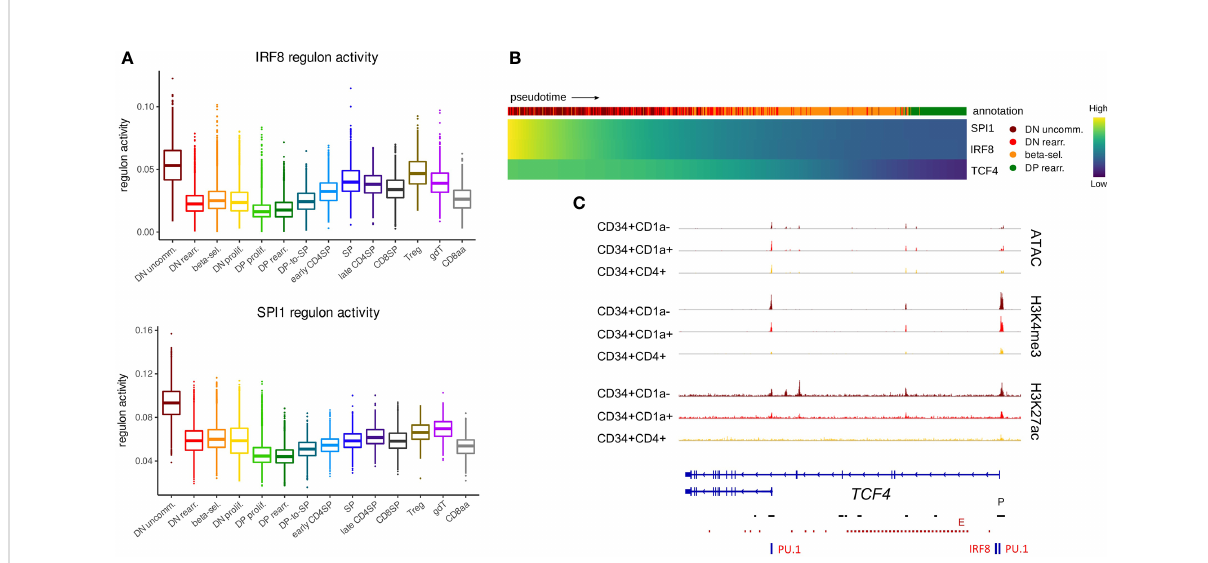
FIGURE 4 TCF4, IRF8 and SPI1 are predicted to form a regulatory network in uncommitted DN thymocytes. (A) Activity of IRF8 and PU.1 regulons per cluster as predicted by running pySCENIC on the single cell data set. (B) Heatmap showing gene expression along differentiation pseudotime in immature thymocytes. Smoothed gene expression was determined based on a generalized additive model fi tted on the cell pseudotimes, cells in pseudotime window of interest were selected and expression was scaled by gene prior to visualization. (C) Genome browser view of ATAC, H3K4me3, H3K27ac and PU.1/IRF8 motifs at the TCF4 locus. Locations of promoters (P) and enhancers (E) were retrieved from the Ensembl Regulatory Build and are indicated below the gene